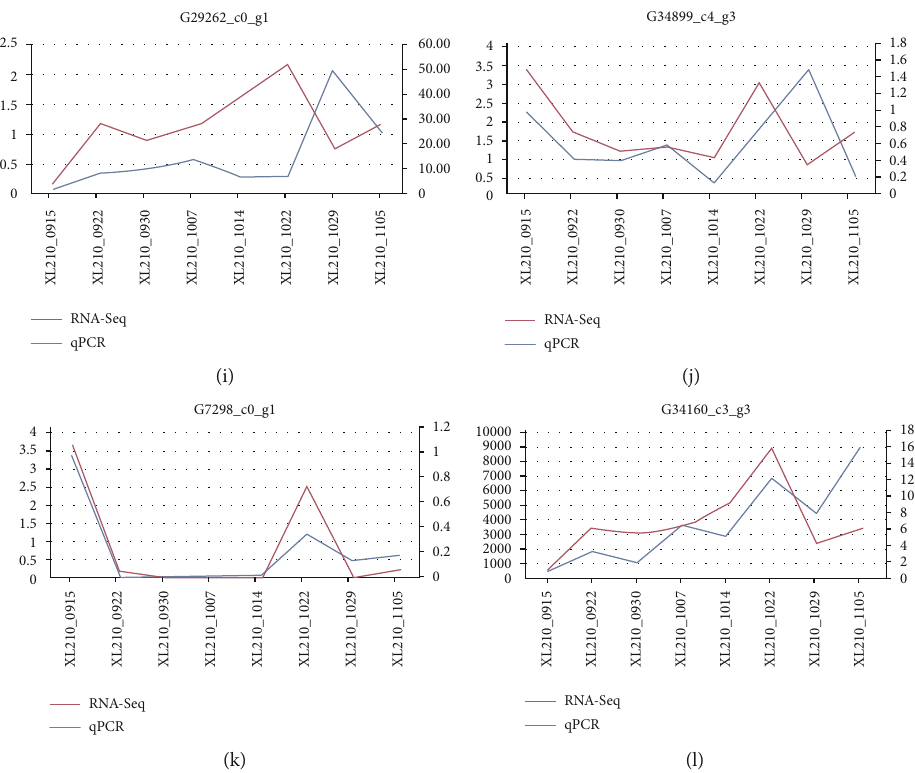
Figure 6: The expression of representative genes in XL210 and XL106 validated by